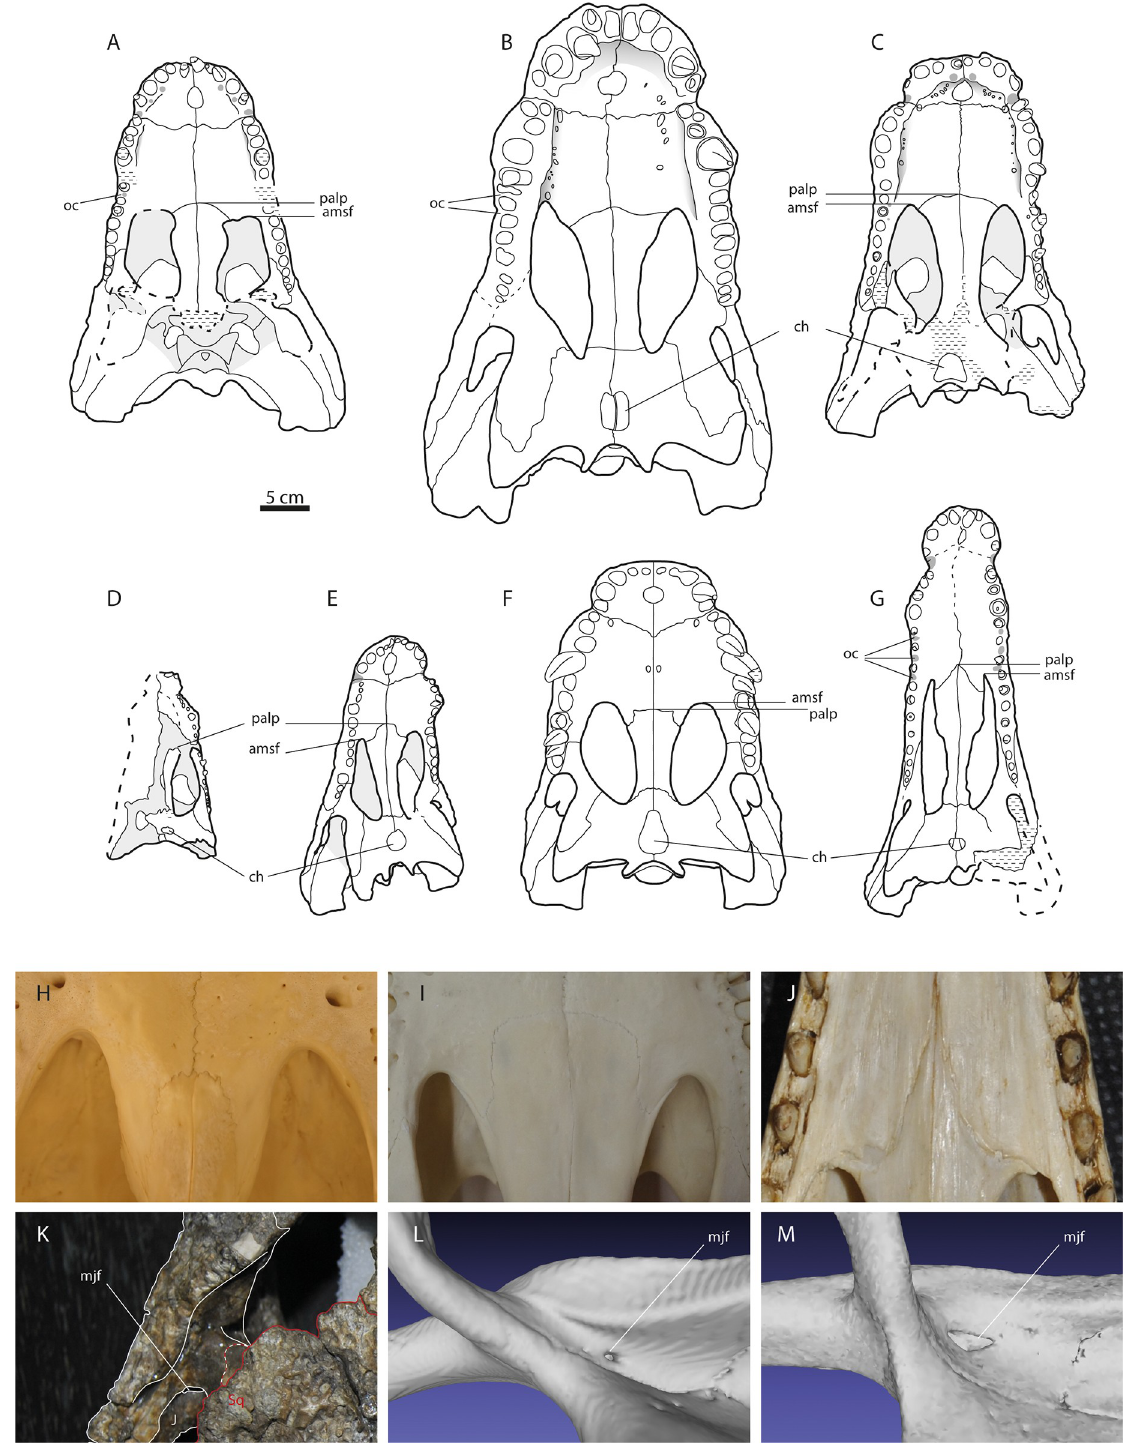
Fig 2. Skulls of allodaposuchid taxa in palatal view. A) Allodaposuchus precedens . B) Allodaposuchus iberoarmoricanus . C) Allodaposuchus subjuniperus . D) Arenysuchus gascabadiolorum . E) ‘ Lohuecosuchus ’ mechinorum . F) ‘ Lohuecosuchus ’ megadontos . G) ‘ Agaresuchus ’ fontisensis . H-J) Detail of the palatine processes in Osteolaemus tetraspis (H), Alligator mississippiensis (I), and Mecistops cataphractus (J). K-M) Detail of the jugal and the medial jugal foramen in A . subjuniperus (K), Alligator (L) and Tomistoma (M). Fig J and K, courtesy of Dr. Eduardo Pue´rtolas Pascual. Fig N and M are details of CT-scans, courtesy of Dr. Josep Fortuny.